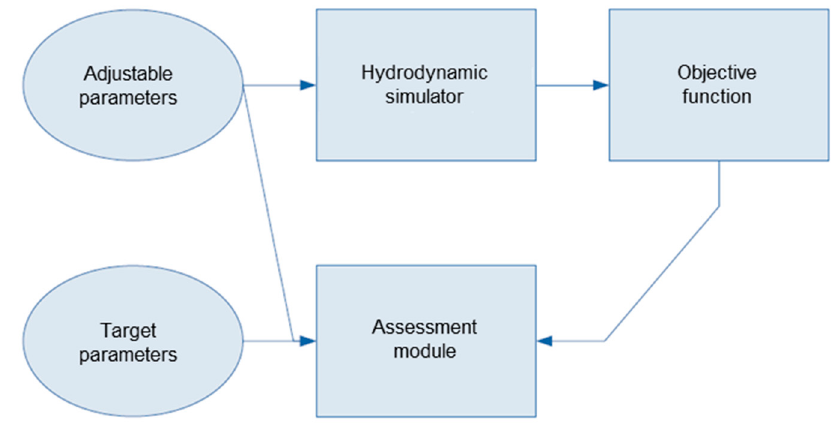
Figure 3. Assessment module training.